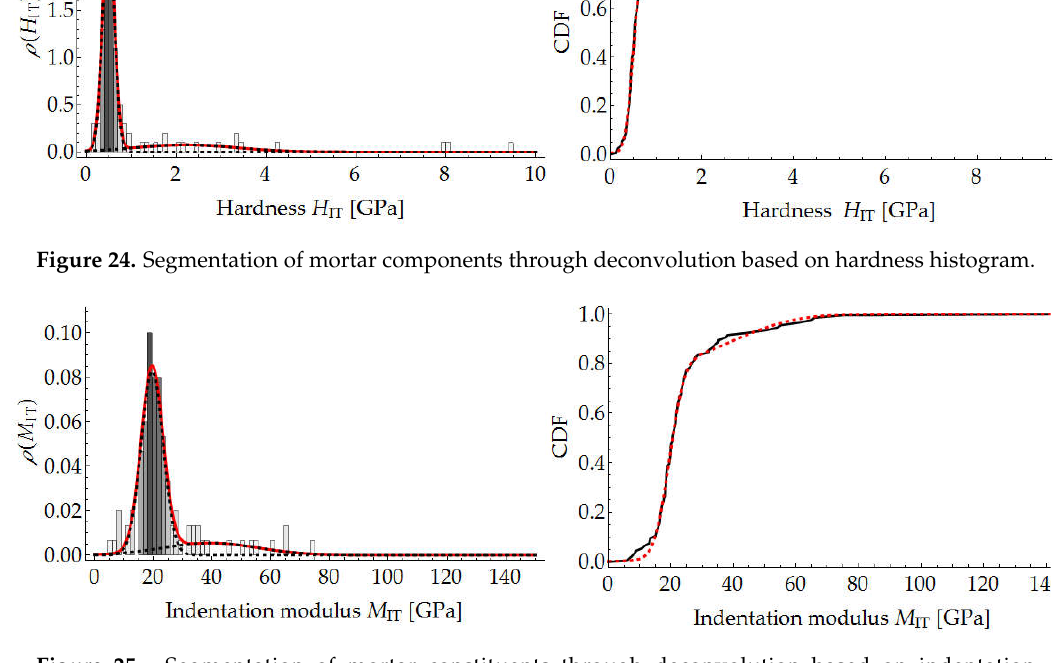
Figure 25. Segmentation of mortar constituents through deconvolution based on indentation modulus histogram.